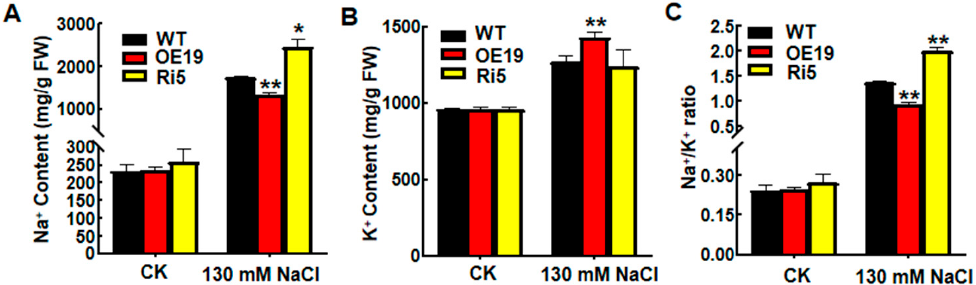
Figure 4. Analysis of Na + and K + content. ( A ) Na + content, ( B ) K + content, and ( C ) Na/K ratio of wild-type (WT) and OsASR6 transgenic plants following 130 mM NaCl and control (CK) treatment, respectively. Three independent experiments were carried out with similar results. Asterisks indicate significant differences between means of WT and transgenic lines. Data represent means ± SD. * p < 0.05, ** p < 0.01.